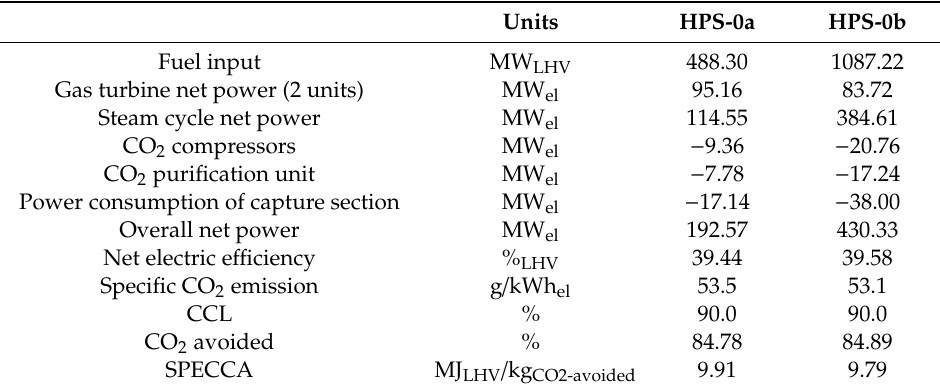
Table 17. High-pressure solvent (HPS) performance evaluation